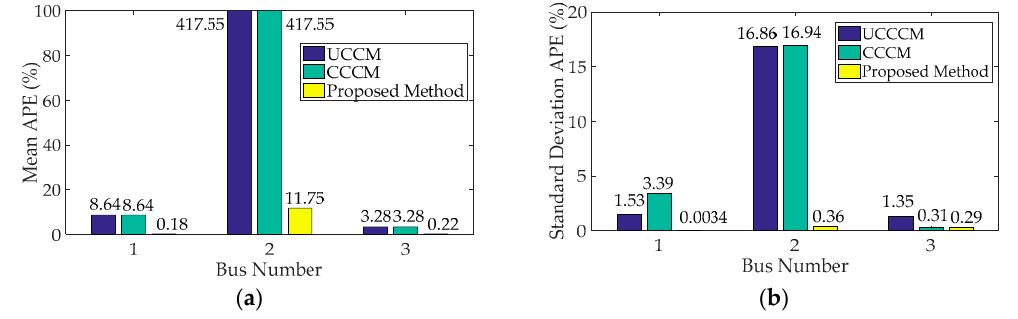
Figure 3. Comparison of APE values of generators’ reactive power (modified IEEE 9-bus test system). ( a ) Mean APE values; ( b ) Standard deviation APE values.